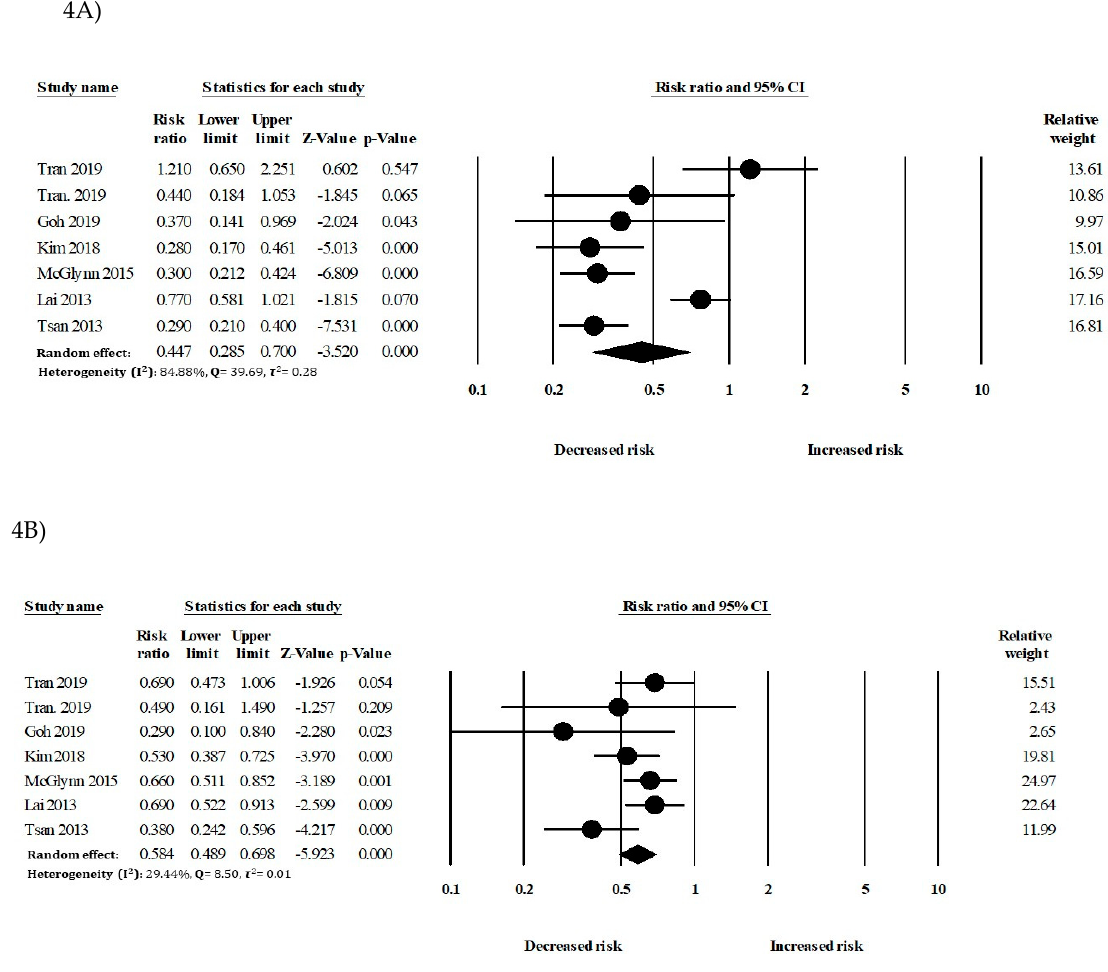
Figure 4. Statin use and the risk of hepatocellular carcinoma (HCC) in patients with ( A ) DM and ( B ) without diabetes mellitus (DM).